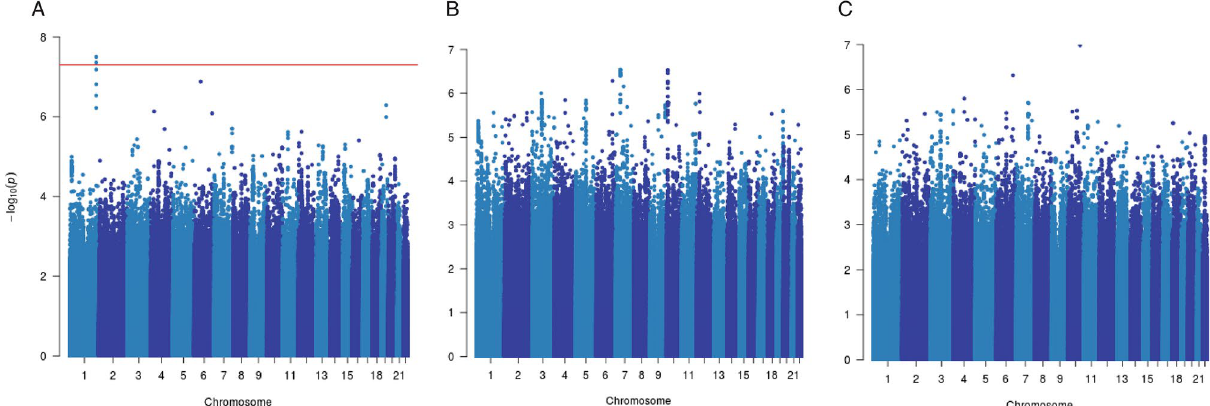
Figure 1. Manhattan plots of the meta-analysis of OncoArray and iCOGS datasets for the association of common germline variants and breast cancer-specific survival for patients with metastases at primary breast cancer diagnosis for ( A ) all breast tumors, ( B ) ER-positive tumors, and ( C ) ER-negative tumors. The y axis shows the − log 10 P values of each variant analyzed, and the x axis shows their chromosome position. The red horizontal line represents P = 5 × 10 −8